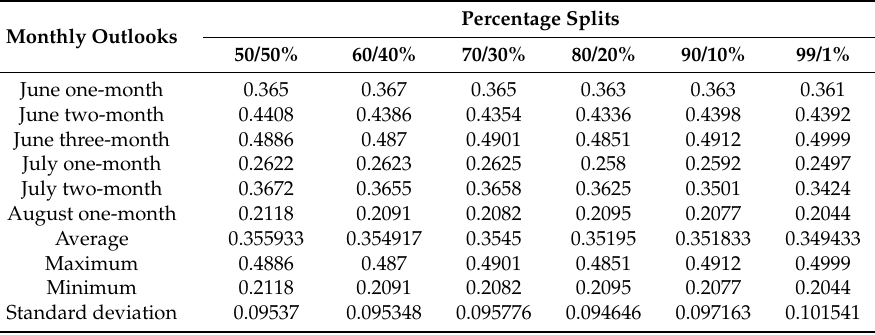
Table 4. Performance of the monthly outlook models for the MAD on the percentage splits.